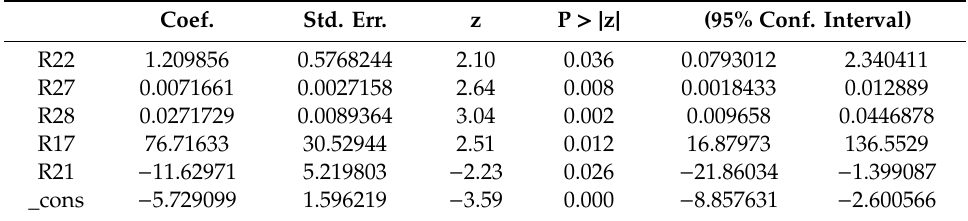
Table 8. Regression results two years before